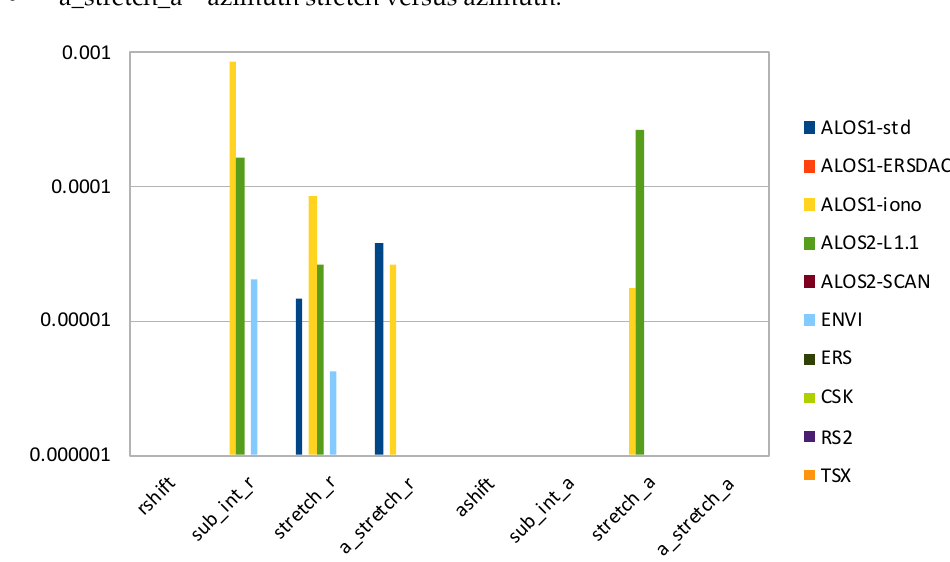
Figure 5. Histogram of relative error (in logarithmic scale) on output values from fitoffset.csh , when cross-correlation is calculated with xcorr-gpu